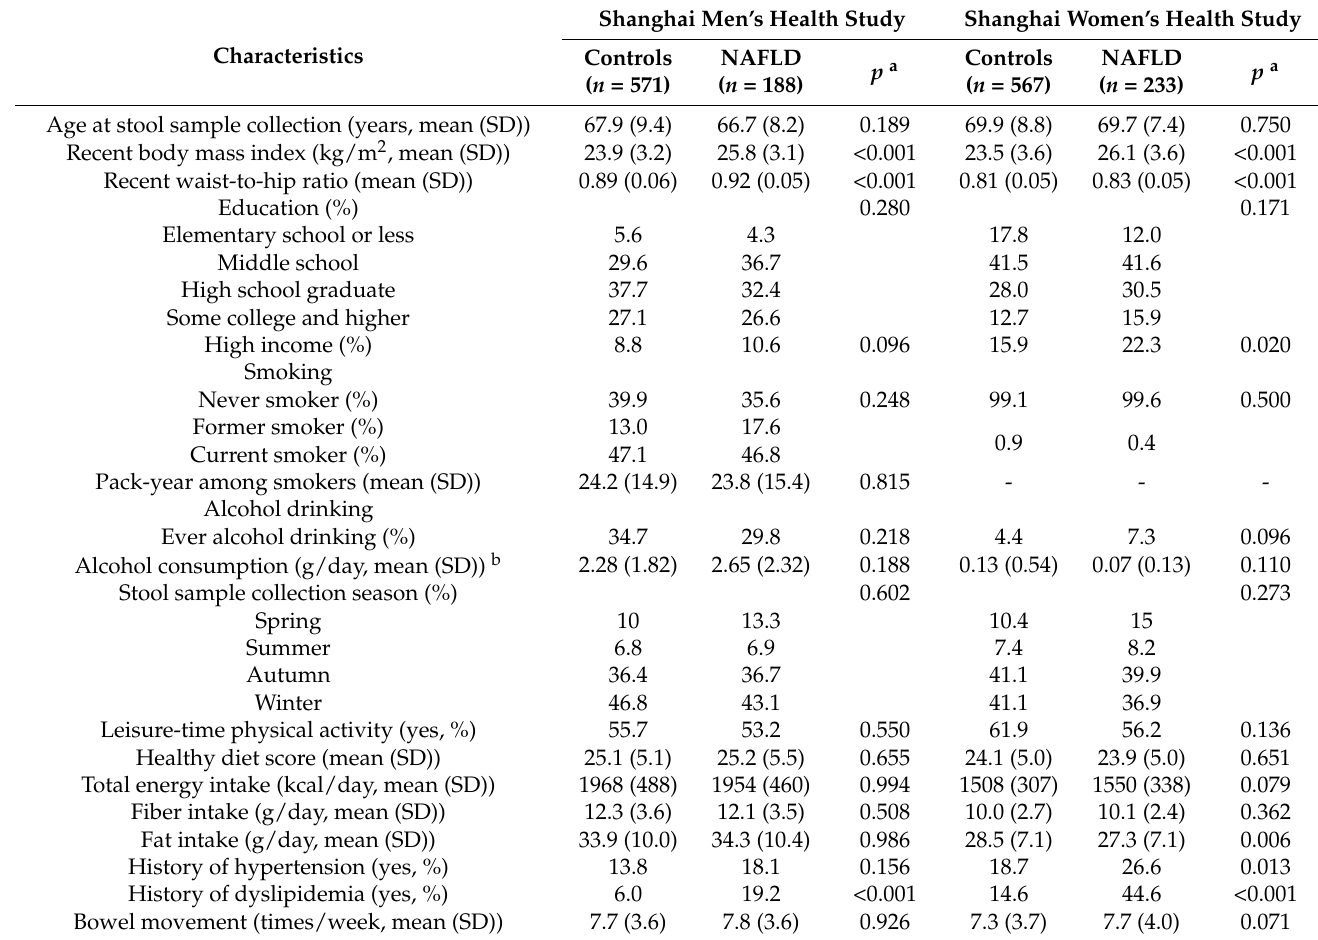
Table 1. Selected characteristics of participants from the Shanghai Men’s and Women’s Health Study.